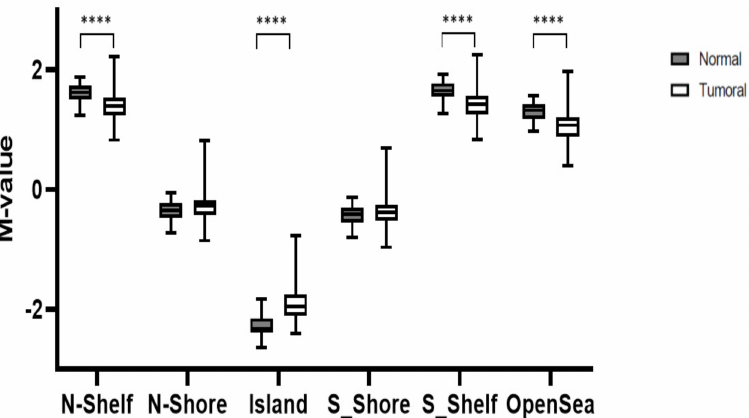
Figure 2. Comparison between normal and tumoral methylation in different locations with respect to CpG island; i.e., (N/S) shores, (N/S) shelves and open sea. **** p < 0.0001.